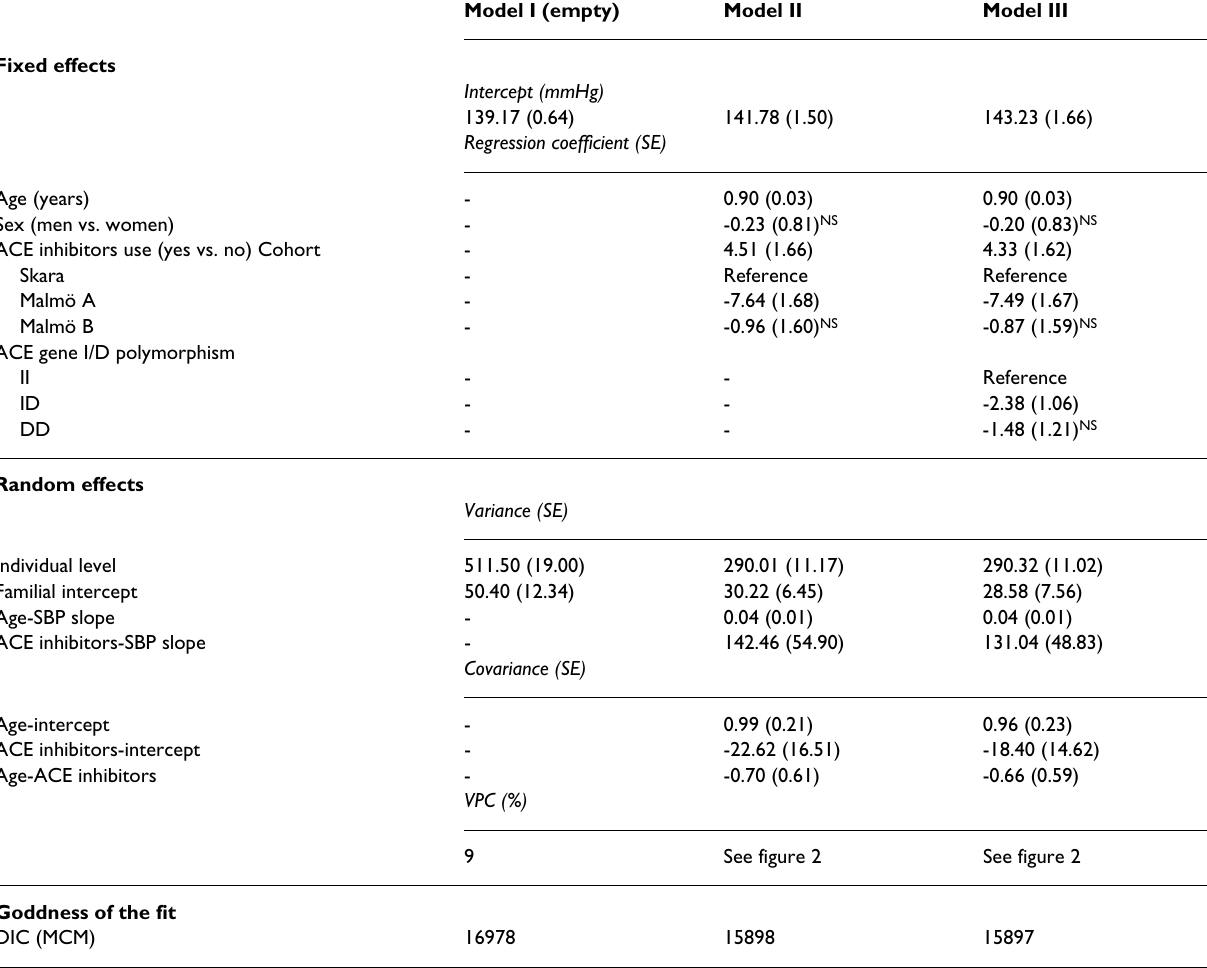
Table 3: Multilevel regression analysis of systolic blood pressure (SBP) in 1926 individuals from 438 Swedish families with